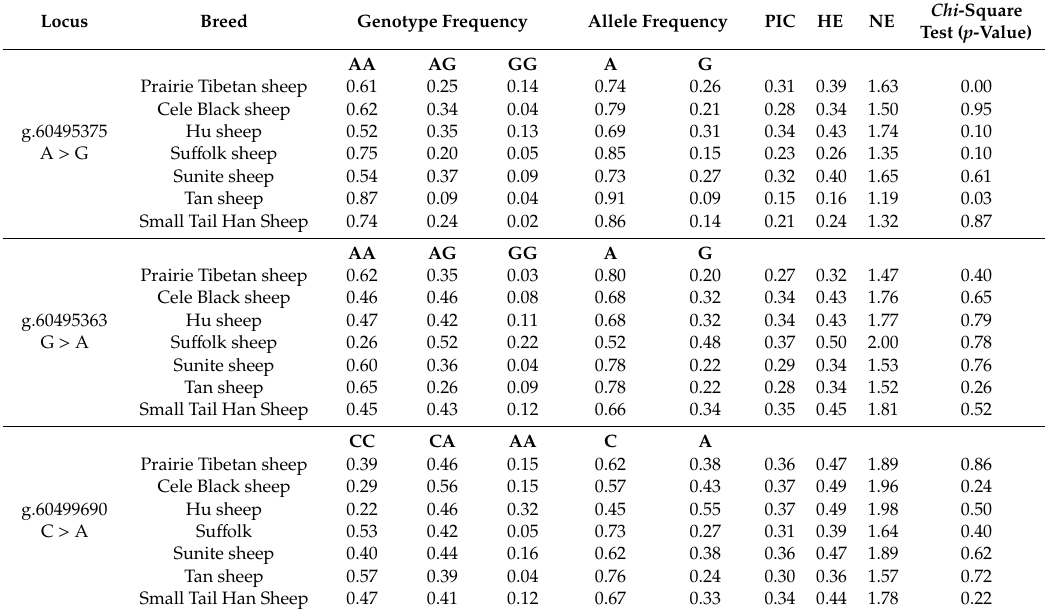
Table 2. Population genetic analysis of three NLR family pyrin domain-containing 5 ( NLRP5 ) loci in seven sheep breeds. Locus